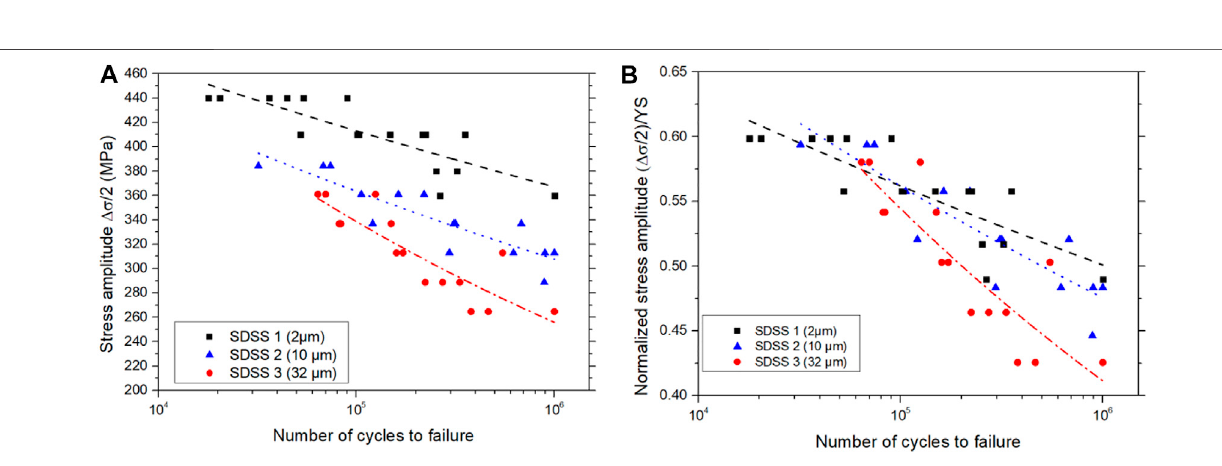
Frontiers in Materials |